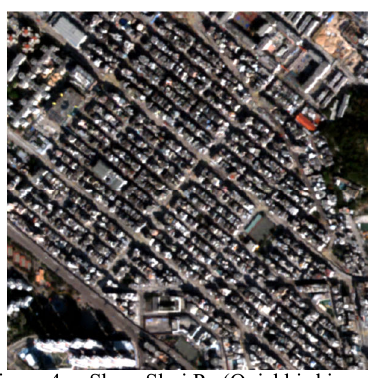
Figure 4. Sham Shui Po (Quickbird image) The results of applying gamma correction and linear correlation correction are examined in three selected areas in Hong Kong. The study areas consist of different environments: shadows from densely distributed buildings; shadows from mountainous terrain; and areas that are close to water bodies. The selected areas are located across the territory of Hong Kong (Figure 1) and can be seen in Figure 2 (Central), Figure 3 (Ma On Shan), and Figure 4 (Sham Shui